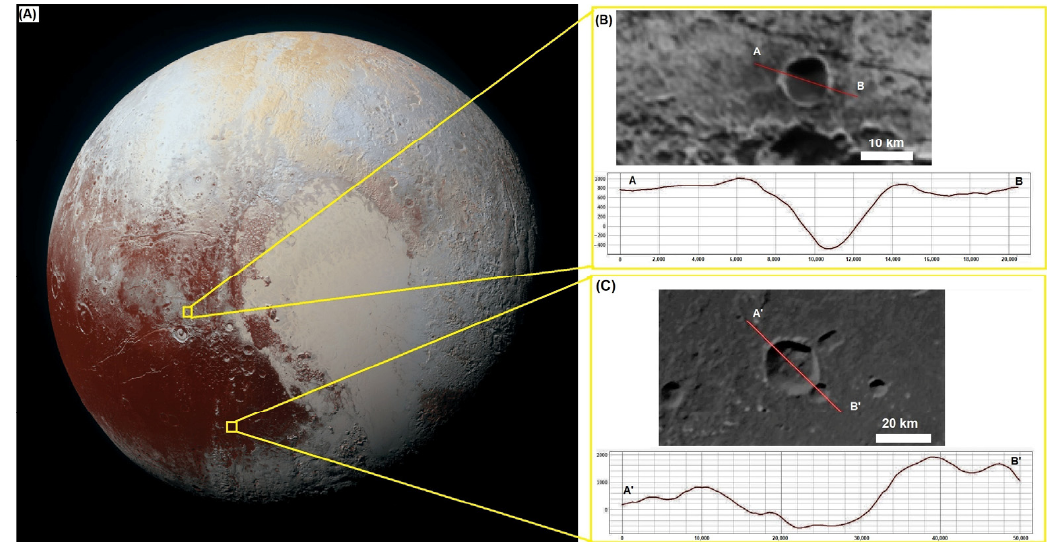
Figure 4: ( A ) Global view of Pluto. The image combines blue, red and infrared images taken by the Ralph/Multispectral Visual Imaging Camera (MVIC) (Credits: NASA). Profiles x and y axis are in meters. ( B ) Well preserved simple impact crater. ( C ) Simple crater with a high level of modification: internal walls with low slope; surrounding craters modify its morphology; rim with uneven height.